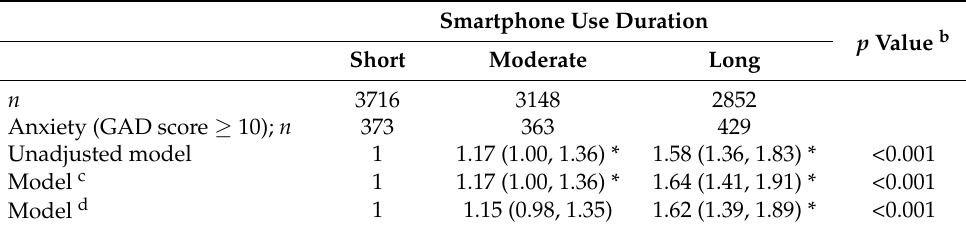
Table 2. Adjusted relationship between smartphone use duration and anxiety in all participants a .